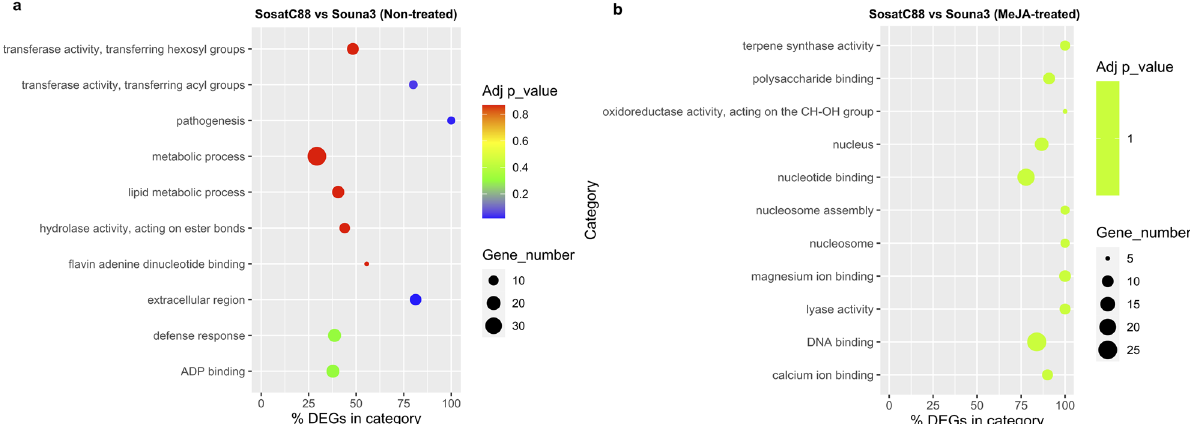
Figure 5. ( a ) The top 10 over-represented GO terms under non-treated condition between SosatC88 and Souna3. ( b ) The top 10 over-represented GO terms under MeJA-treated condition between SosatC88 and Souna3. The Adj p-value is the corrected p-value ranging from 0 to 1.